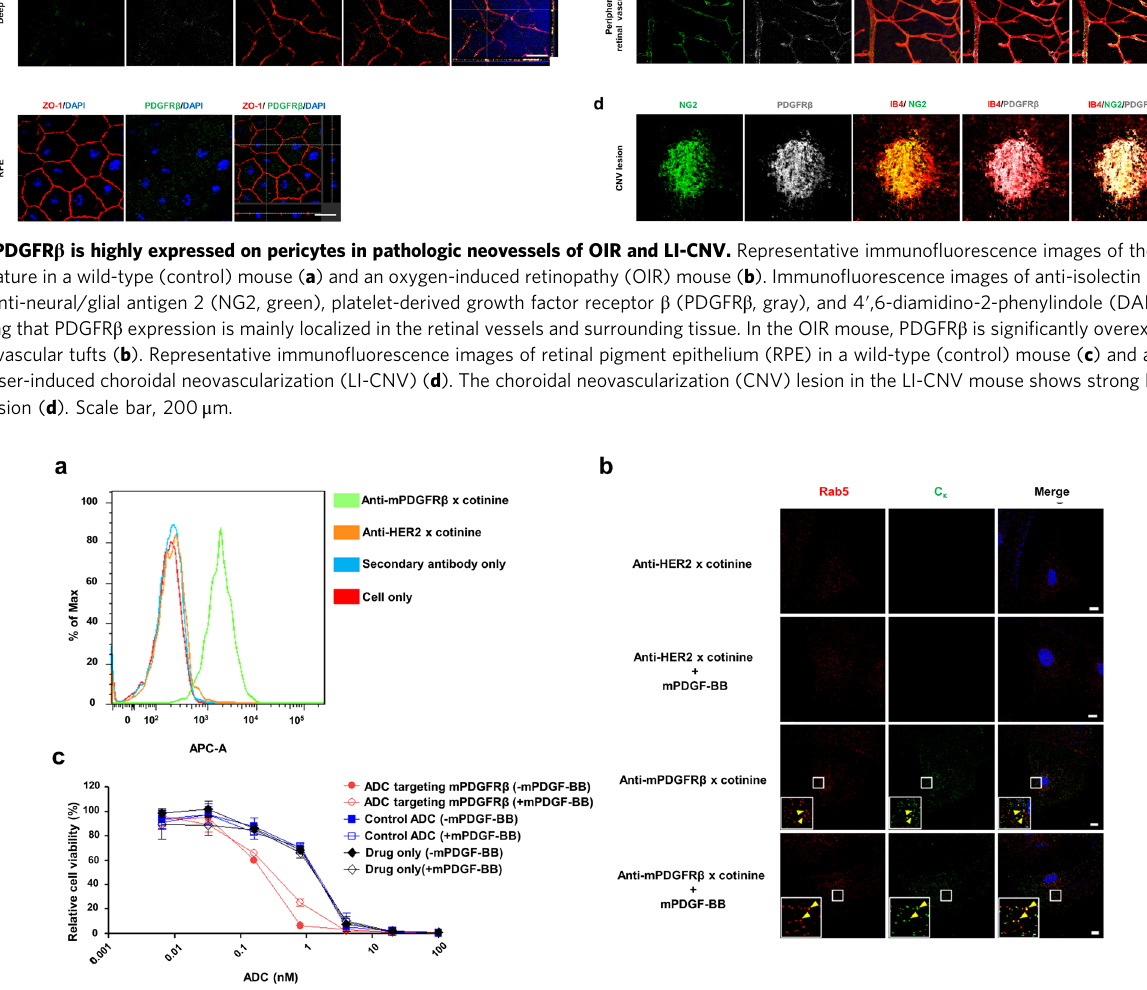
Fig. 2 Preparation and characterization of ADC targeting mPDGFR β . a Flow cytometry of bispeci fi c anti-mouse platelet-derived growth factor receptor β (mPDGFR β ) × cotinine single-chain variable fragment (scFv)- kappa constant (C κ )-scFv fusion proteins (anti-mPDGFR β × cotinine). Mouse brain vascular pericytes (MBVPs) were treated with anti-mPDGFR β × cotinine and probed with APC-conjugated anti-human C κ antibody. As a control, anti-human epidermal growth factor receptor 2 (HER2) × cotinine scFv-C κ -scFv fusion protein (anti-HER2 × cotinine) was used; anti-HER scFv was derived from trastuzumab. b Confocal microscopy of the internalization of anti-mPDGFR β × cotinine. MBVP cells were incubated with scFv-C κ -scFv fusion proteins with or without mPDGF-BB. Scale bars in the inset image and on the bottom right correspond to 1 μ m and 10 μ m, respectively. c Cytotoxicity of antibody-drug conjugate (ADC) targeting mPDGFR β . MBVP cells were treated with ADC in the absence ( − ) or presence ( + ) of mPDGF-BB. The relative cell viability was calculated using the cellular ATP level. Anti-HER2 × cotinine complexed with cotinine-duocarmycin was used as a control ADC and drug only refers to cotinine-duocarmycin in fresh media. The results are shown as means ± standard deviation (SD) from triplicate